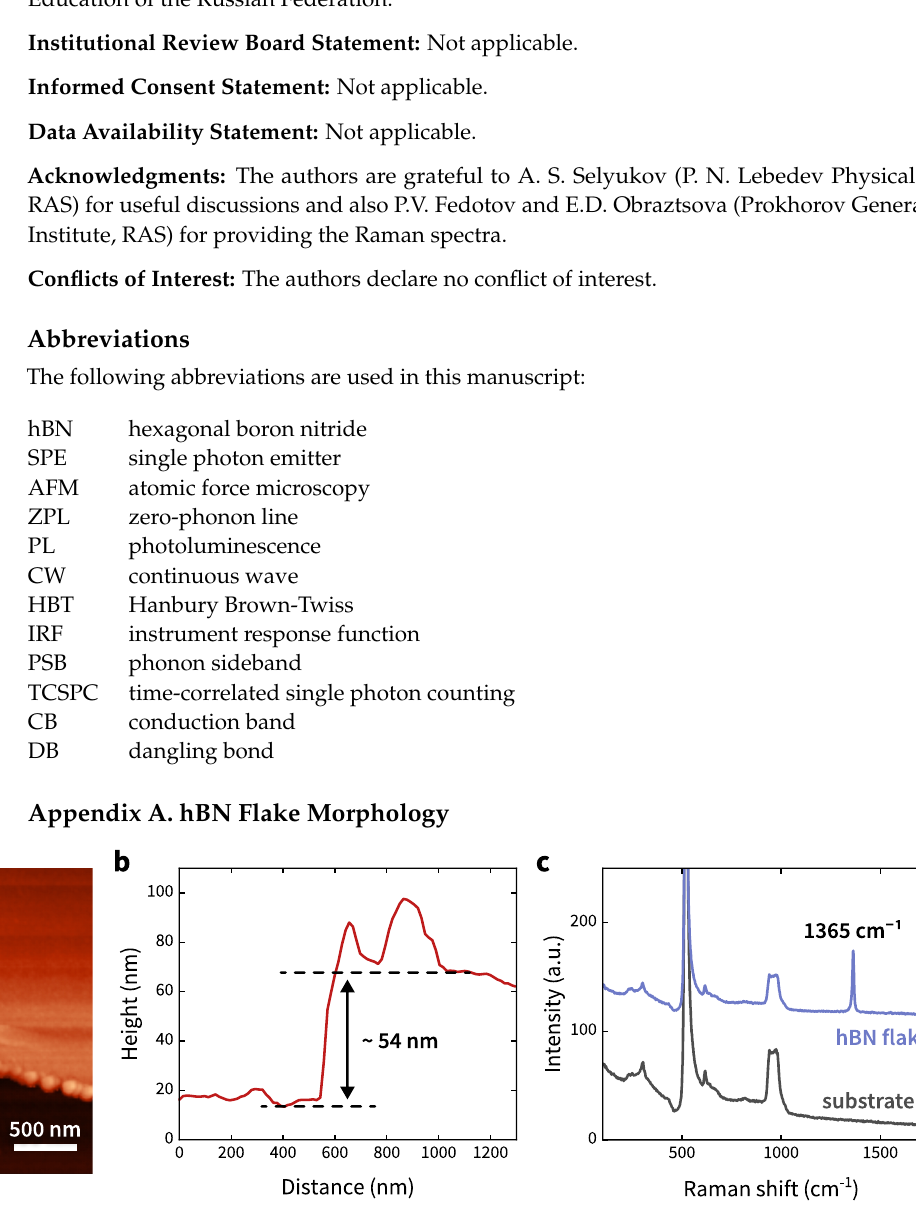
Figure A1. ( a ) AFM image of the hBN flake region and height profile ( b ) of the marked line in ( a ); ( c ) Raman spectra of the hBN flake on a silicon